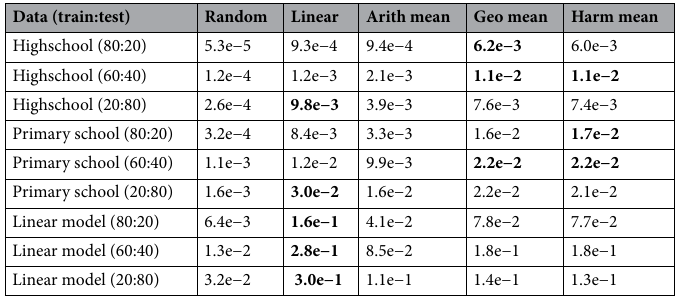
Table 1. AUC-PR for triangle prediction on high-school contact data and synthetic hypergraphs from the linear model. Highest values are indicated in